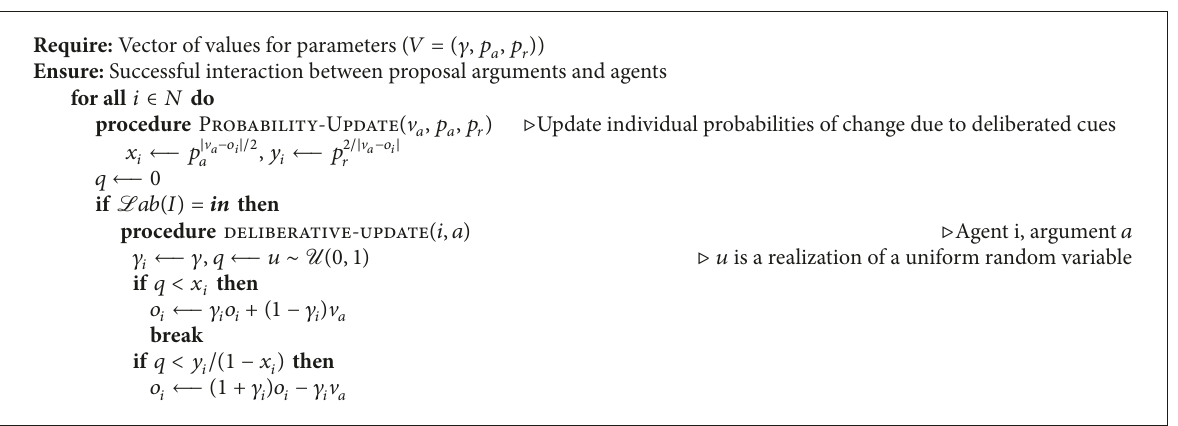
Algorithm 2: Deliberation